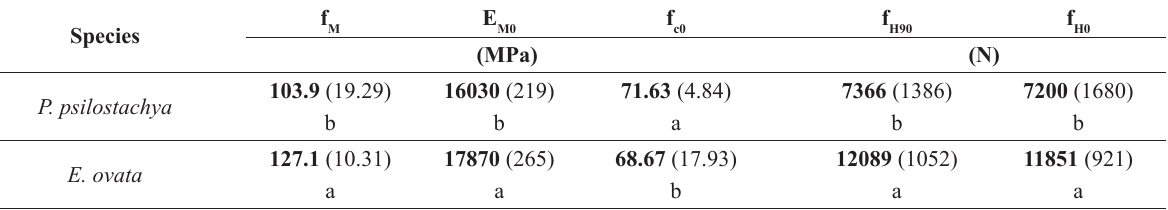
Mechanical properties of wood of the studied species. Mean values followed by standard deviation, between parentheses, and letters representing the statistical group, where different letters in the same column indicate significant statistical difference between treatments.